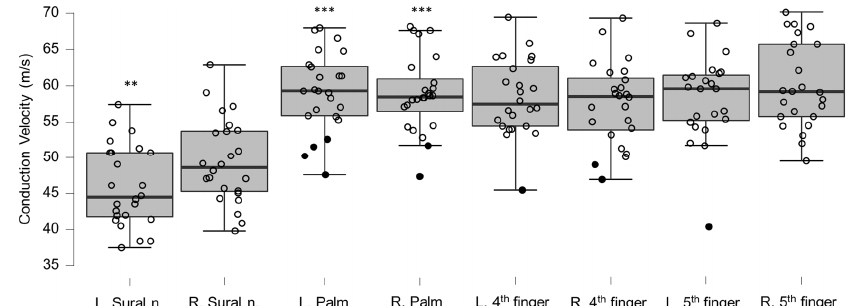
Figure 11. Box-plots for sensory neurography conduction velocities. Lower and upper box bounda-